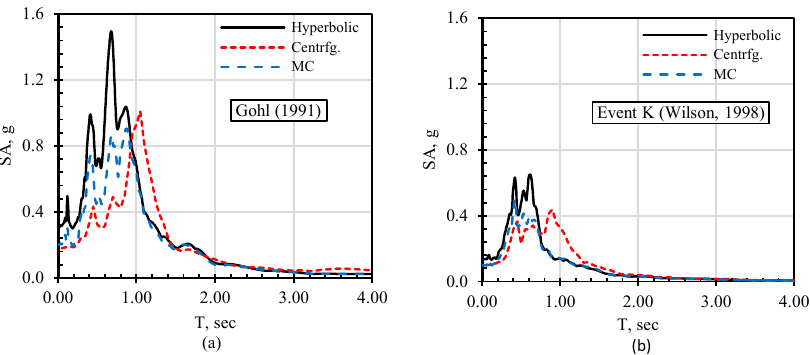
Figure 8. ARS of the structure (D = 5%) for verification analyses (Case 1): ( a ) Gohl [30] and ( b ) Wilson [31] (Event K).